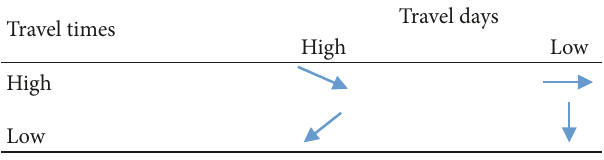
Table 5: Four layouts of travel behavior graph.